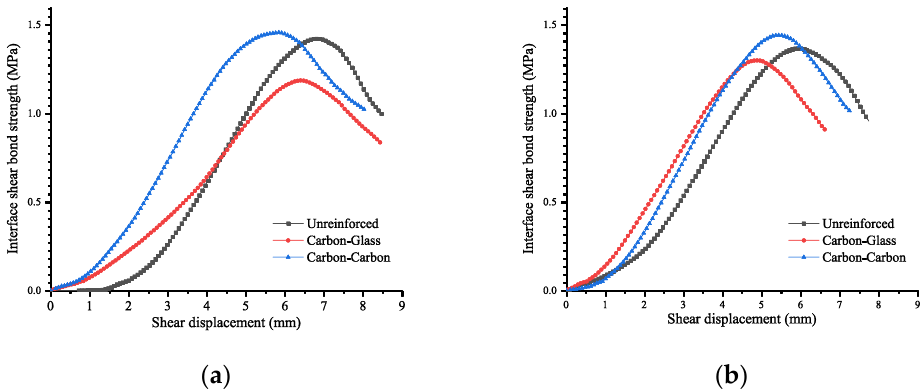
Figure 7. The results of the oblique shear tests.